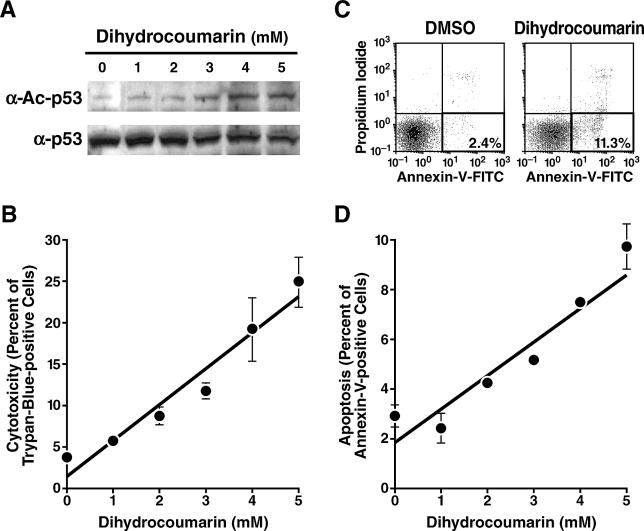
DHC Increases p53 Acetylation, Cytotoxicity, and Apoptosis in the TK6 Cell Line(A) DHC increases p53 lysine 373 and 382 acetylation in a dose-dependent manner in the TK6 cell line following a 24-h exposure period. The immunoblot is representative of three separate experiments.(B) DHC increases cytotoxicity in a dose-dependent manner following a 24-h exposure to DHC. The average ± standard error for each of three experiments is shown.(C) A 5-mM dose of DHC increases apoptosis at the 6-h time point in the TK6 cell line. A combination of annexin V fluorescein isothiocyanate and propidium iodide staining was used to discriminate among apoptotic (lower-right box) and necrotic (upper-right box) cells. Figures are representative of three separate experiments.(D) DHC increases apoptosis in a dose-dependent manner in the TK6 cell line at the 6-h time point. The average ± standard error for three experiments is shown.